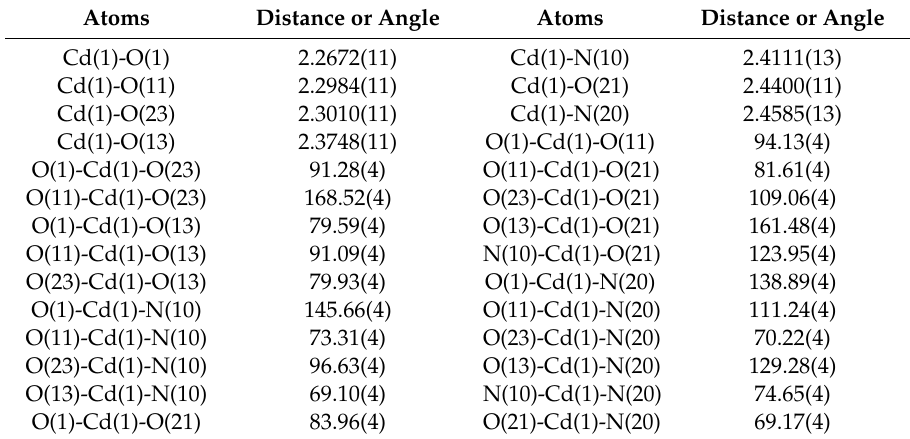
4. Geometric features of the hydrogen bonds in the crystal structure